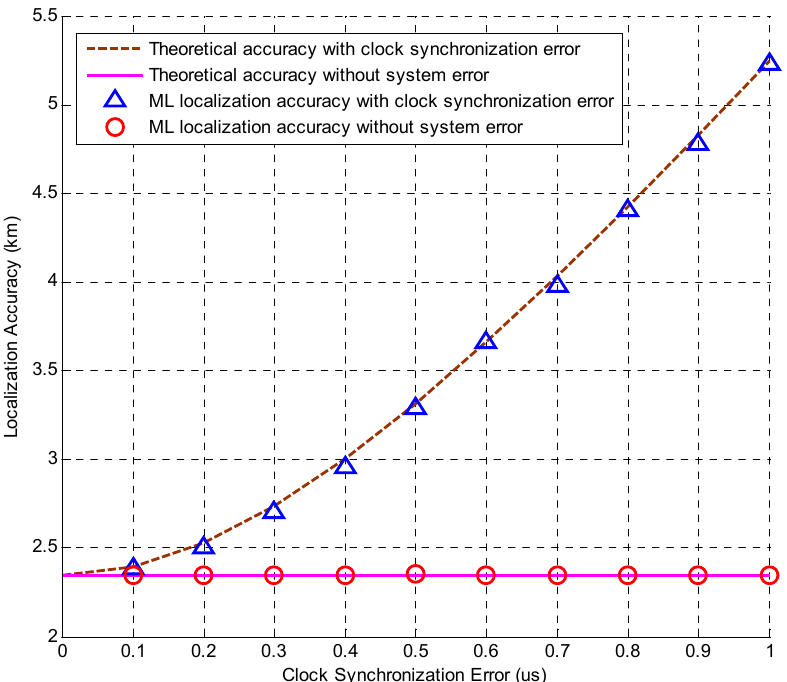
Figure 3. Localization accuracy comparison using the GEO and LEO satellites by varying clock synchronization error.